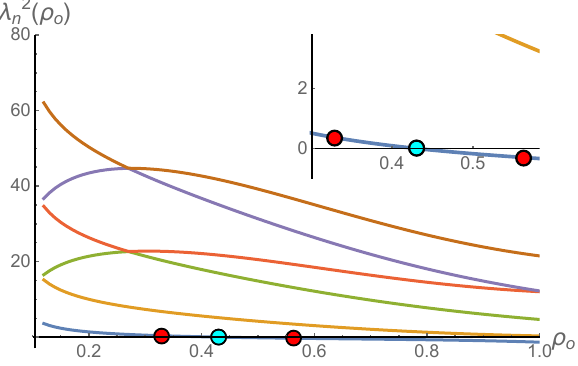
Figure 5 . Evolution of the linearized eigenmodes along the line (cid:26) b = 0 : 09. The red and cyan dots corresponds to the same solutions as in (cid:12)gure 4. The stability threshold occurs at (cid:26) o = 0 : 425 and corresponds to the cyan dot where ! b reaches its maximal value along the (cid:26) b = 0 : 09 curve. Turning points of physical quantities are natural locii for the onset of linear